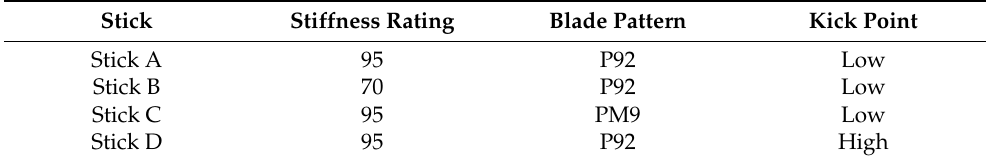
Table 2. Specifications of the four sticks used during testing. Stick A was used as a “baseline” implement. Stick B varied in stiffness. Stick C varied in blade pattern. Stick D varied in kick point.